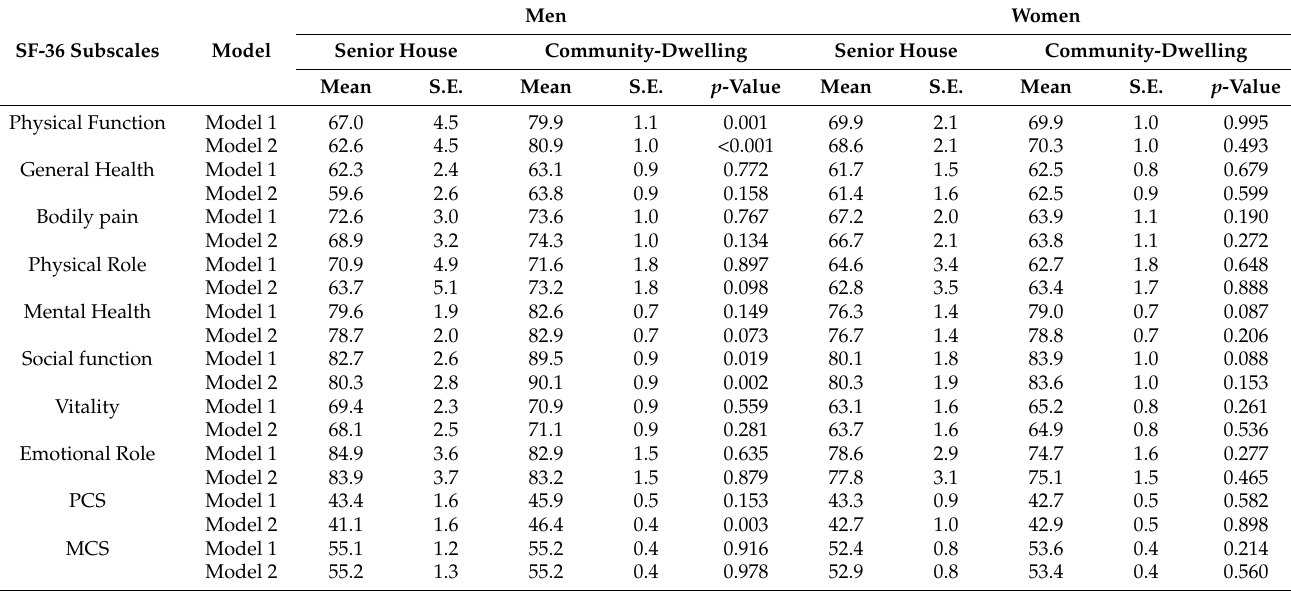
Table 2. Mean values for the eight SF-36 subscales and physical and mental summary scores among men and women in the two housing groups using the general linear model (GLM).